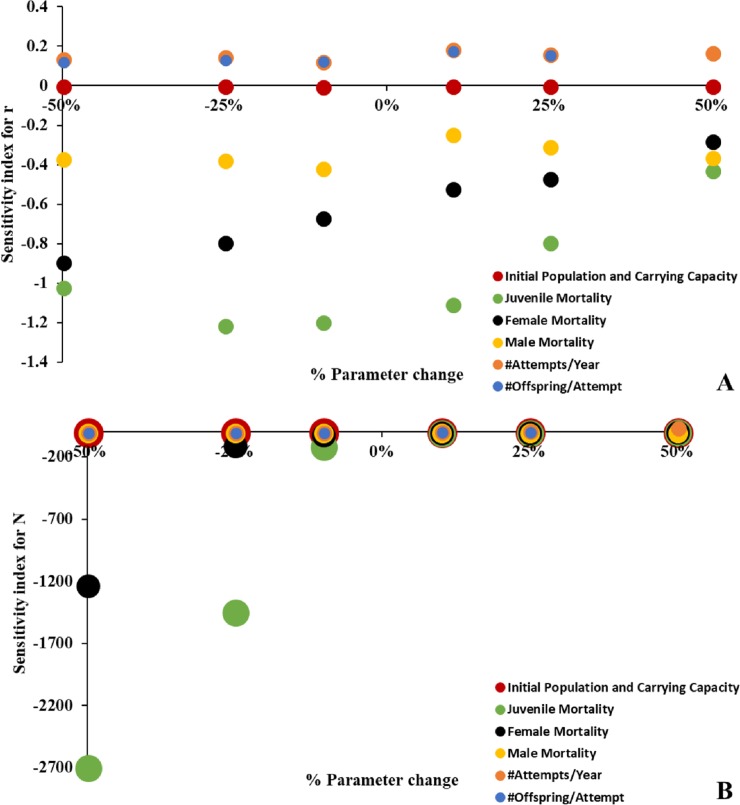
Sensitivity index (SI) of growth rate (A) and final population size (B). Increased distance from X axis (sensitivity index of 0) indicates more sensitivity.